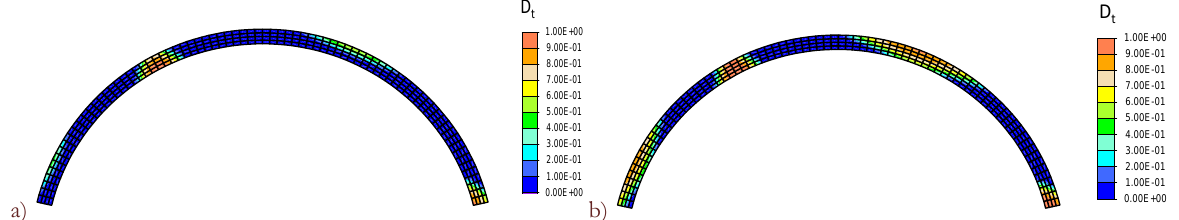
Figure 7: Tensile damage map: a) time step A; b) time step B;